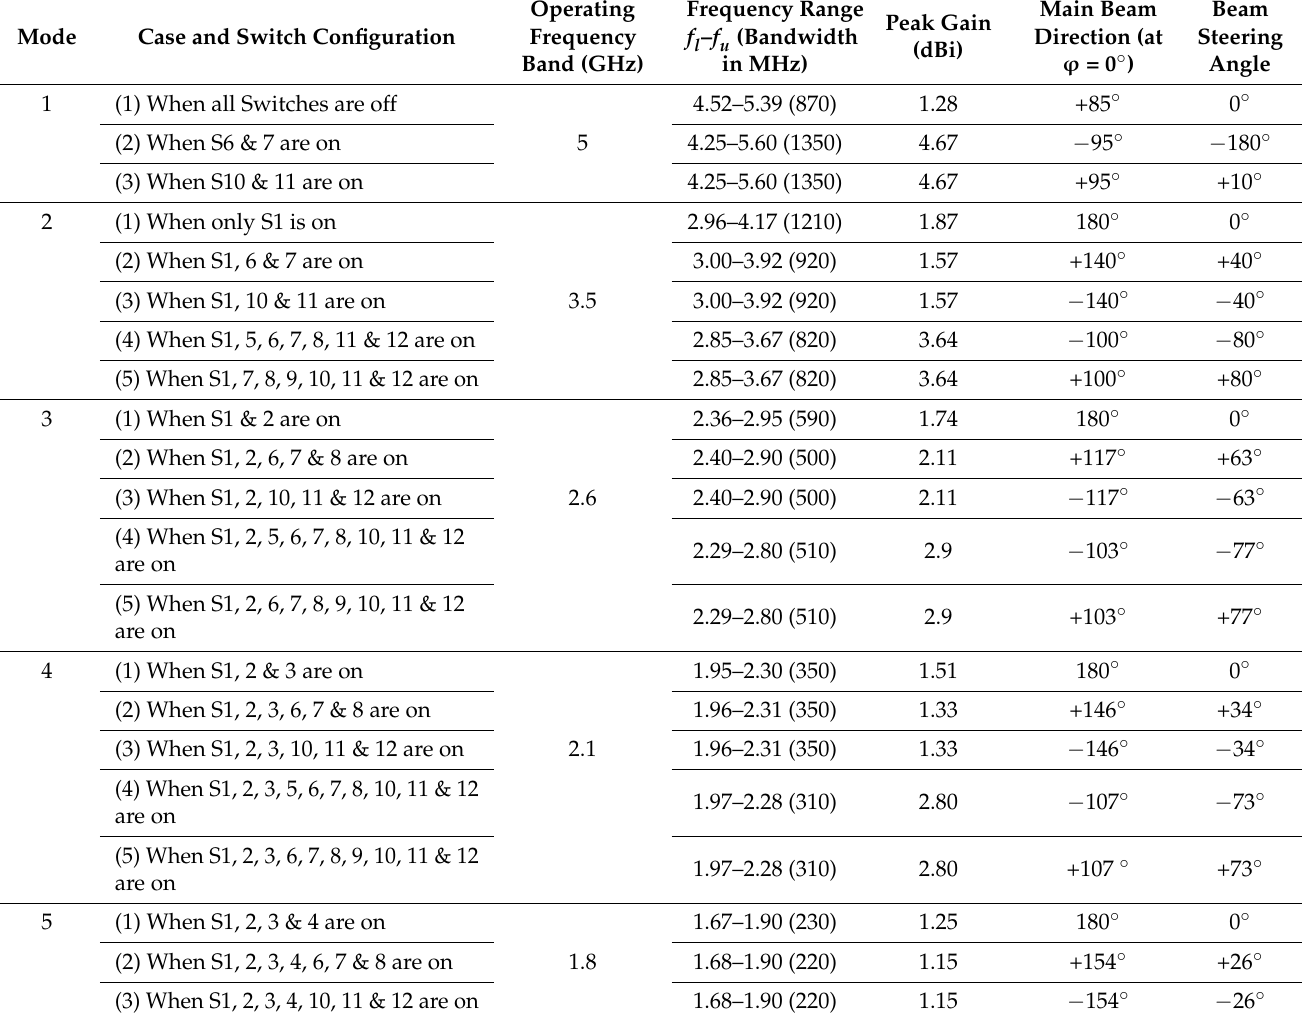
Table 3. Performance parameters of design